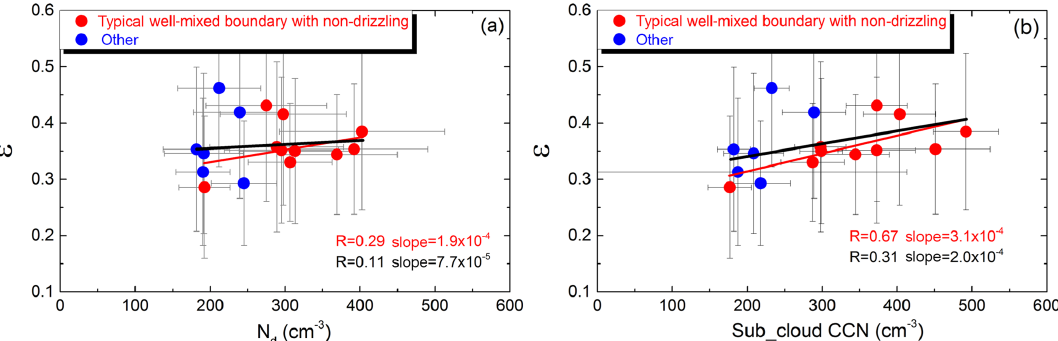
Figure 10. Relative dispersion ( ε ) as a function of (a) N d and (b) sub-cloud CCN concentrations (SS = 0 . 2%) for all flights. The error bars through these symbols indicate the standard deviation. Red symbols are the cases with typical well-mixed BL, and blue symbols are for other cases. Red (black) texts are the correlation coefficient and slope for typical well-mixed cases (all